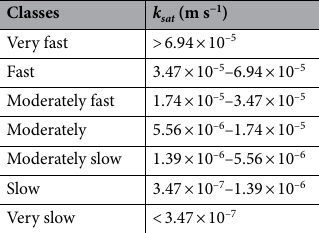
Table 1. Saturated hydraulic conductivity classes established by Ferreira (1999) apud Freire et al. 24 .